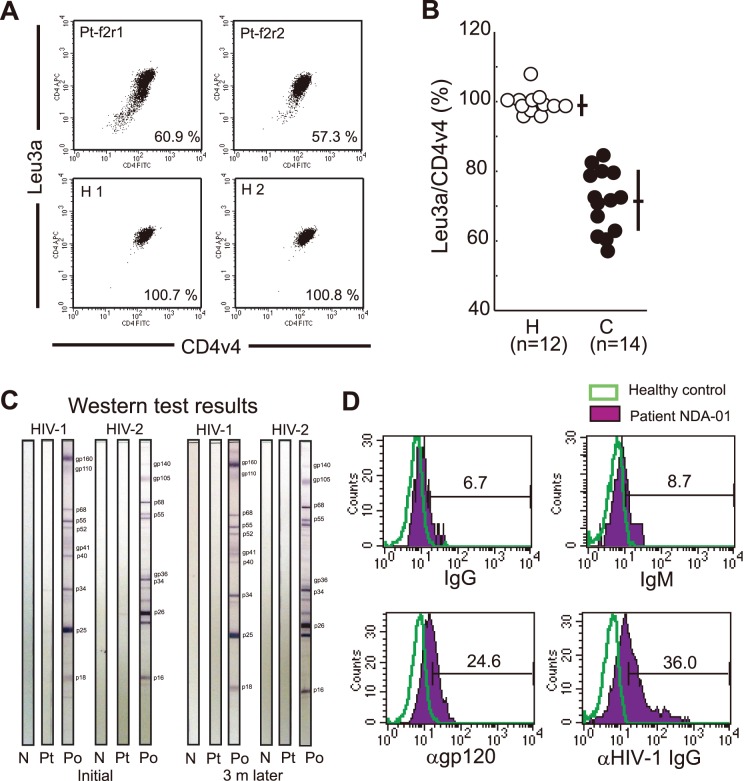
rCD4s from HIV-1+ Pts are coated with gp120.(a) Representative FACS data from rCD4s purified from healthy controls (H1, H2) or chronic asymptomatic patients (Pt-f2r1, Pt-f2r2) stained with Leu3a and CD4v4 (numbers in FACS plots indicate percentages of MFIs of Leu3a/CD4v4). (b) Summary of results of percentages of MFIs of Leu3a/CD4v4 in purified rCD4s from healthy controls (H) and chronic asymptomatic patients (C; CD4 counts: 420±84.6 (± SD); IgG+ rCD4s: 75.5±12.6% (± SD)). (c, d) Detection of cell-bound gp120 on rCD4s in a patient with low anti-gp120 Ab levels. (c) Western blot test results for the HIV-1+ Pt (NDA-01) at initial admission and three months after. N, negative control; Pt, patient serum; Po, positive control. HIV-1 infection was defined as detectable amounts of plasma HIV-1 RNA (1.5×105 copies/ml at initial admission), a positive antibody test (HIV1/2 ELISA), and low CD4+ T cell counts (38 cells/µl). Plasma HIV-1 env and gag region sequences revealed that the patient was infected with a clade B HIV-1. (d) FACS data from rCD4s stained with anti-IgG (upper left), anti-IgM (upper right), anti-gp120 (rabbit anti-gp120 antiserum) (lower left), or purified IgG from pooled serum from HIV-1+ Pts (lower right).